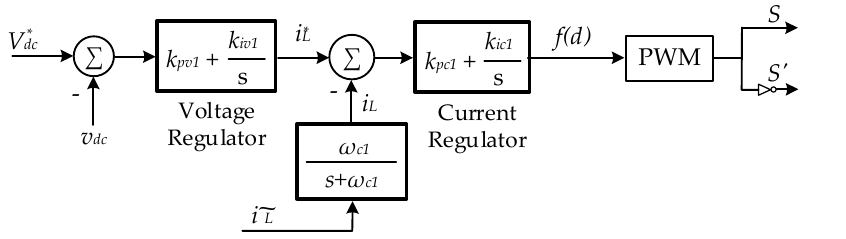
Figure 11. BDC control diagram when operating with SC.